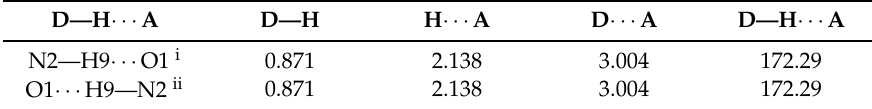
Table 1. Hydrogen-bond geometry (Å, ˝ ) of 10a .